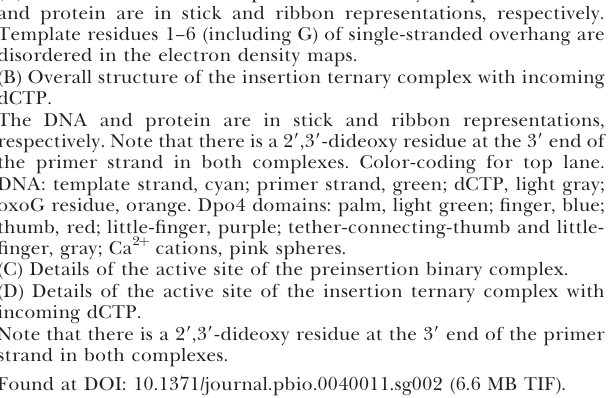
Figure S3. Structural Equivalence of Preinsertion and Postinsertion oxoG-Modified Binary Complexes